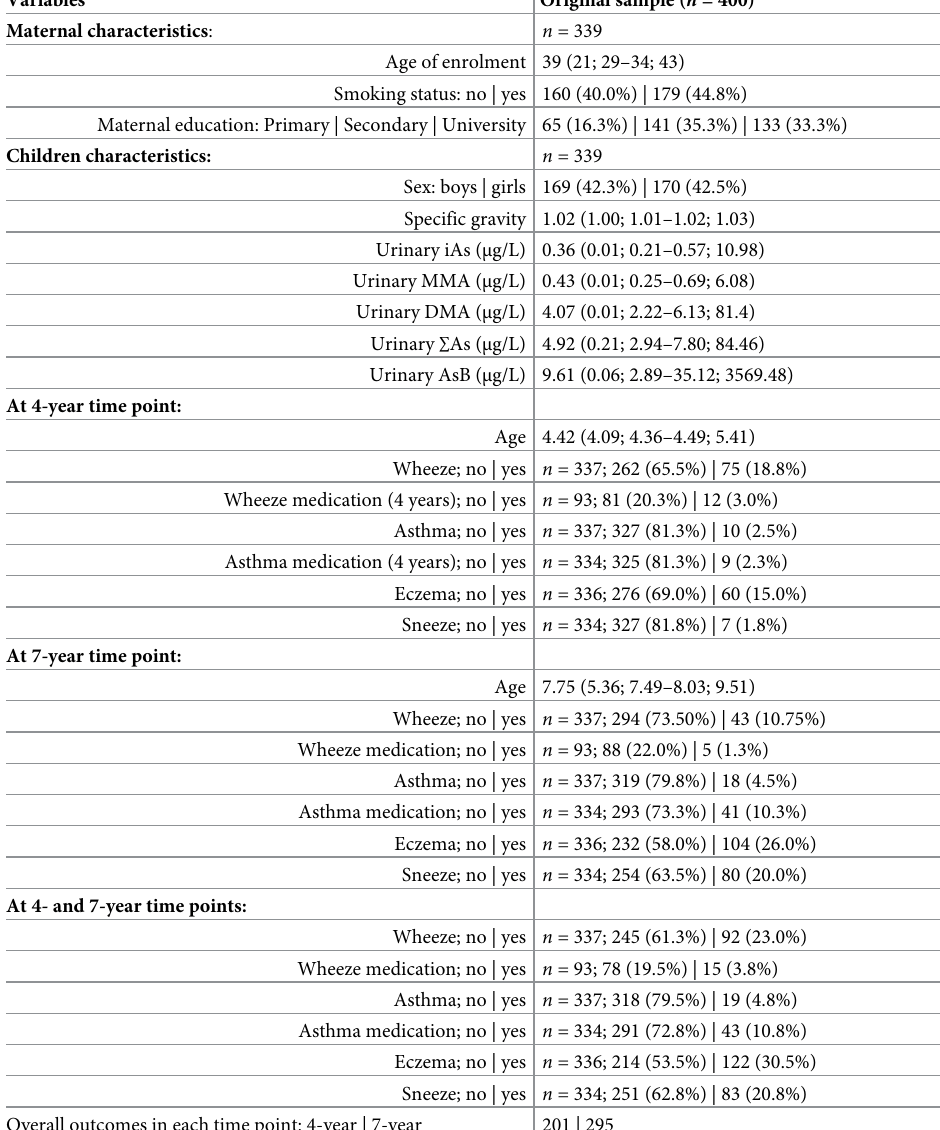
Table 1. Selected characteristics of study mothers and children from